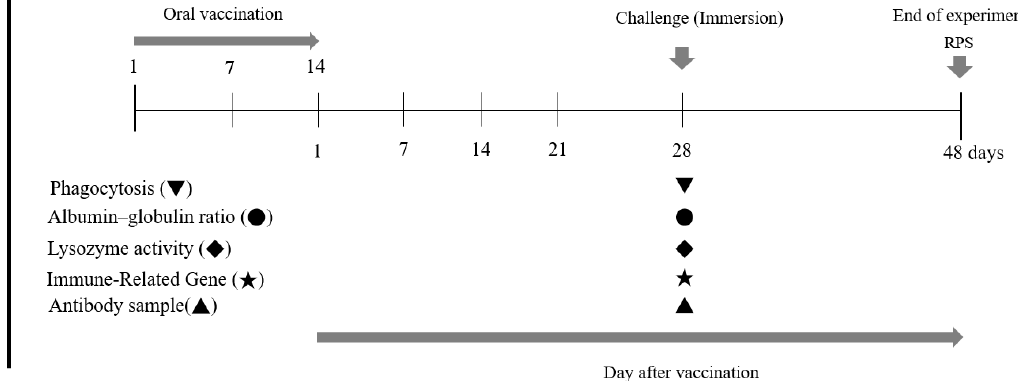
Figure 1. Graphical overview of the vaccination/challenge schedule and sampling time points.